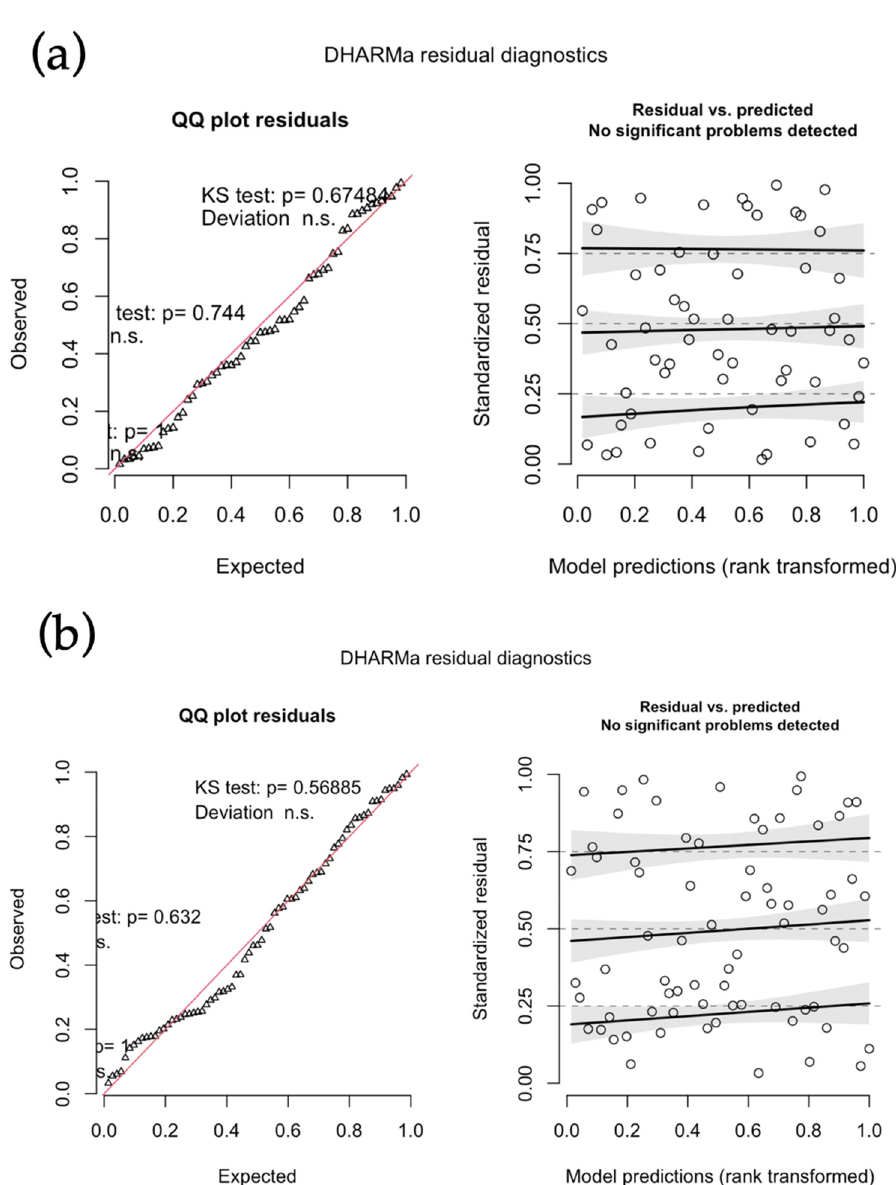
Figure A1. Diagnostic plots showing no significant problems detected in ( a ) GLMMs relating the effects of different predictors on the ant species richness in the agricultural matrix, and in ( b ) GLMMs relating the effects of different predictors on the ant species richness in the ecological infrastructures. Table A1. Description of the GLMMs relating the effects of different predictors on the ant species richness in the agricultural matrix. Models are ranked in ascending order of AIC values and the number of parameters in the model (K), log-likelihood (logLik), AICc, Δ AICc, and AICc weight ( ω i) are given for each model. The “+” signal means the inclusion of the nominal variables in the models.